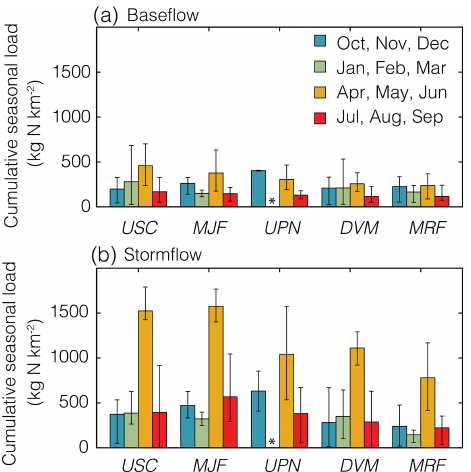
Figure 6. Seasonal NO − load (kgN/km 2 ) normalized by water- 3 shed area, averaged over 4 years of analysis (2016–2019), for each watershed for baseflow periods (a) and stormflow periods (b) . Wa- tersheds are ordered by the density of drainage infrastructure from highest (USC) to lowest (MRF). Error bars show the range of loads measured over the 4-year period. Insufficient data were available to estimate winter loads in UPN and are indicated with an asterisk ( ∗